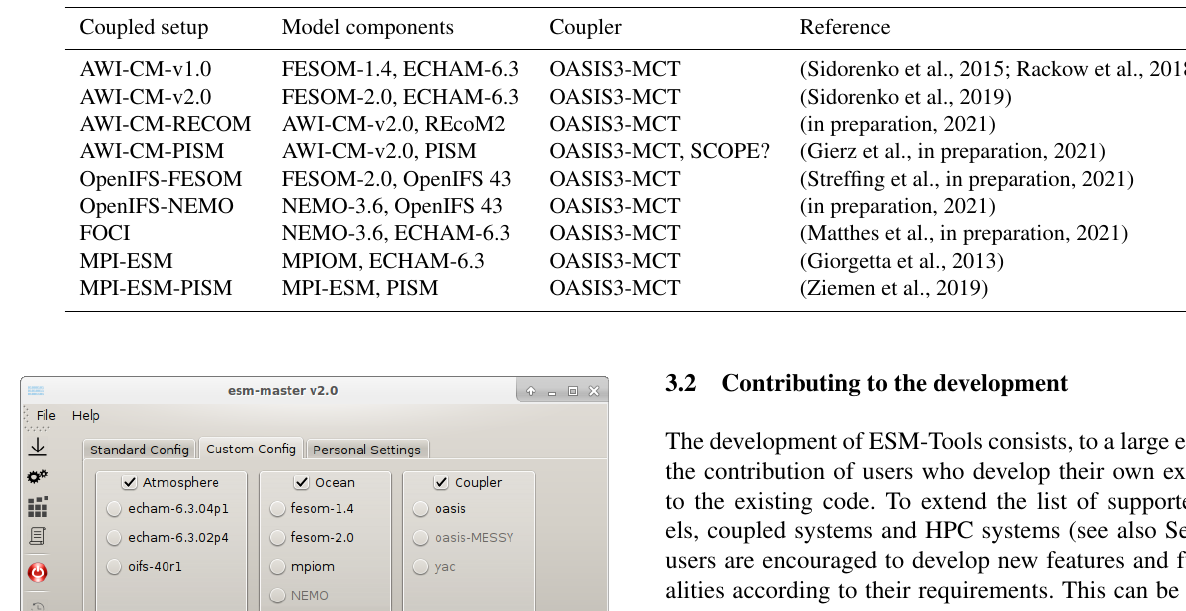
Table 3. Supported coupled setups.